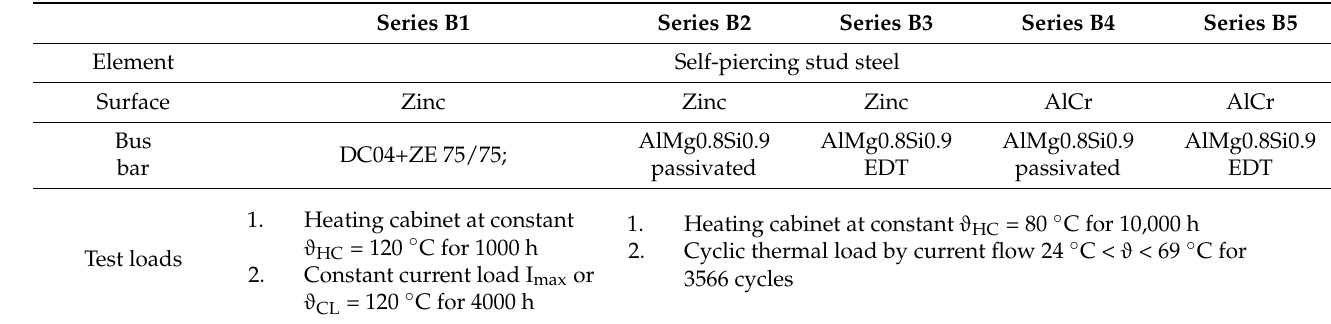
Table 1. Overview of self-piercing